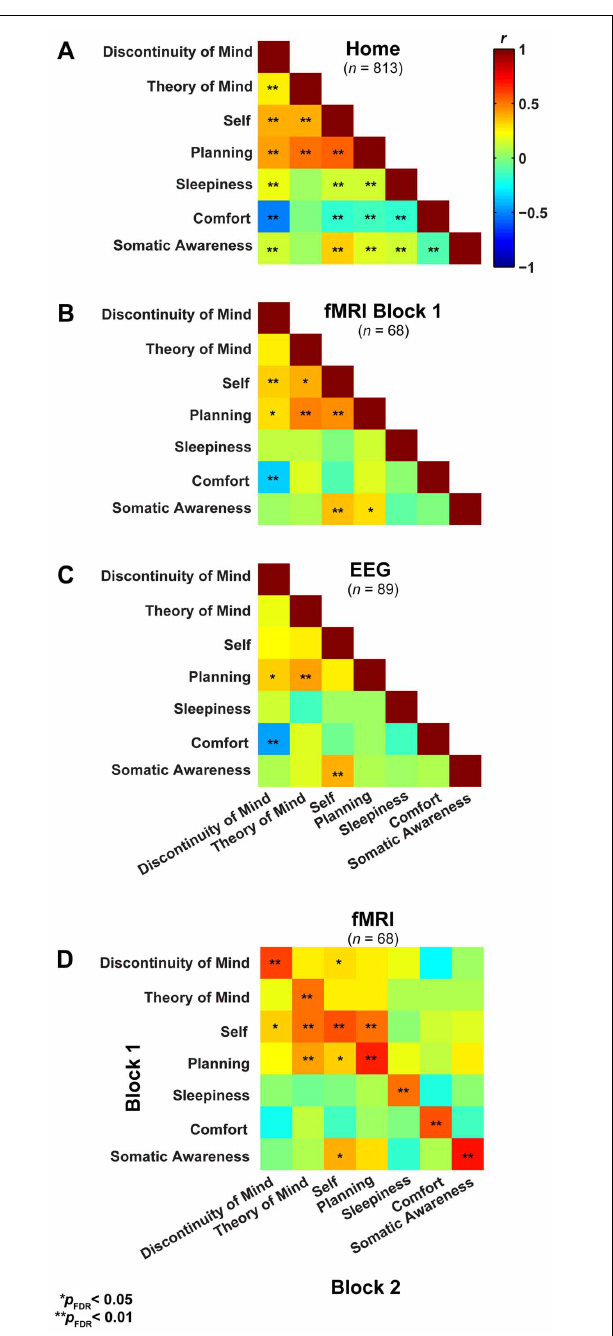
(A) Lower triangular Pearson correlation matrix of resting-state cognition factors derived from the NSR participants in their home environment. (B) The same correlation matrix derived for subjects filling in the ARSQ immediately after a resting-state fMRI experiment (1st block) and while still lying in the scanner. (C) Data from participants in EEG studies reveal a similar pattern of inter-factor correlations to that in (A) and (B) . (D) The correlation of the factor scores between the first and second resting-state block of the fMRI sample shows strong retest correlations